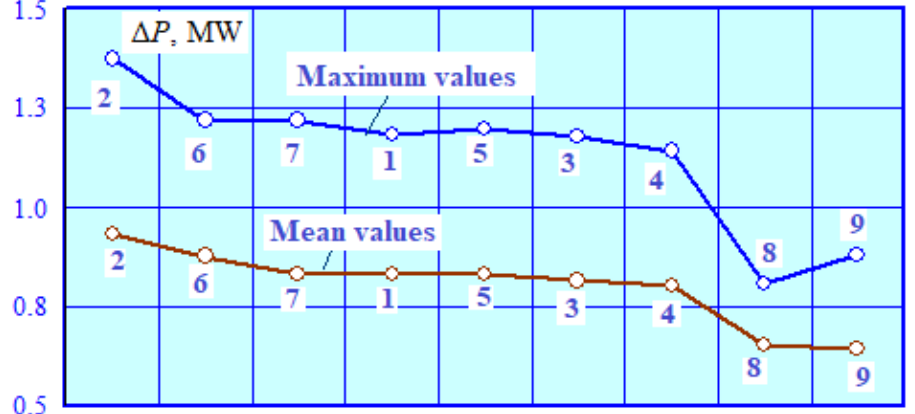
Figure 18. Power losses in the transmission line 1: callout numbers correspond to those of Figure 15. Total cross-sections of conductors differ slightly across all transmission lines.